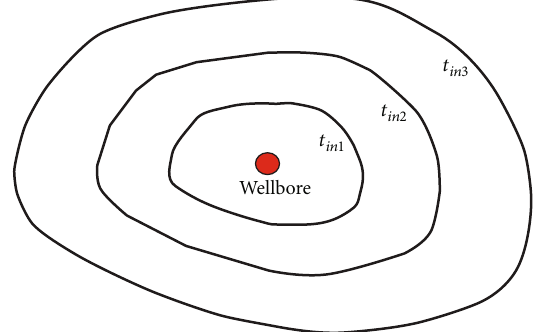
Figure 18: Boundary of VOI as a function of time ( t